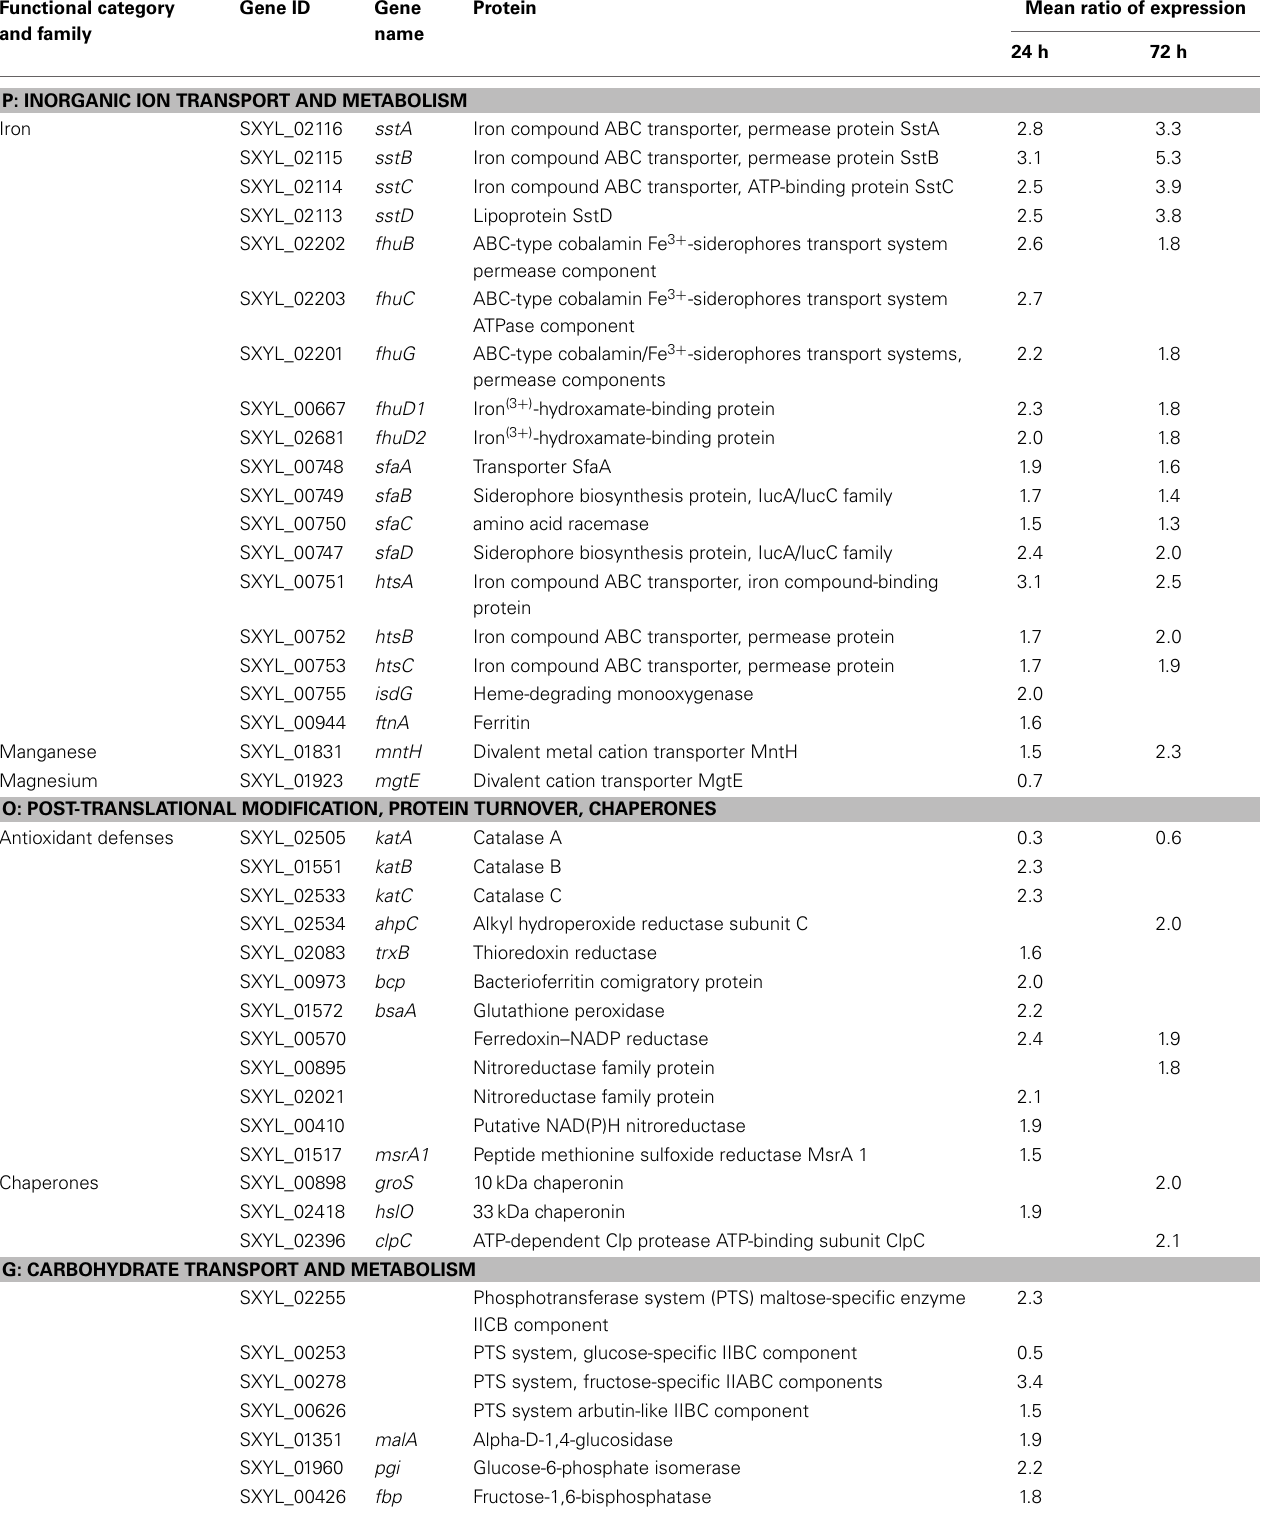
Table 1 | Genes of Staphylococcus xylosus discussed in this study differentially expressed over time in meat in the presence of nitrate and